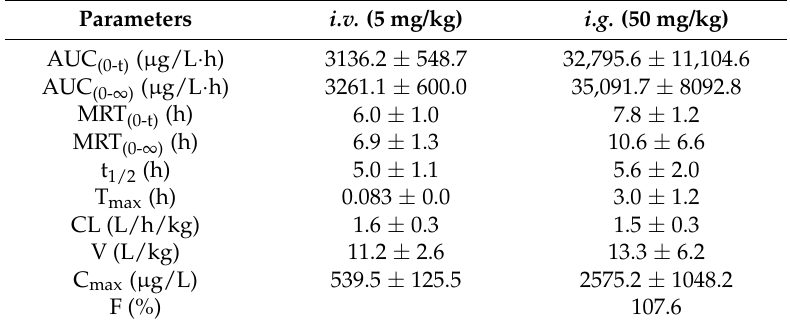
Table 4. Pharmacokinetic parameters of gomisin D in two groups (mean ± SD, n =